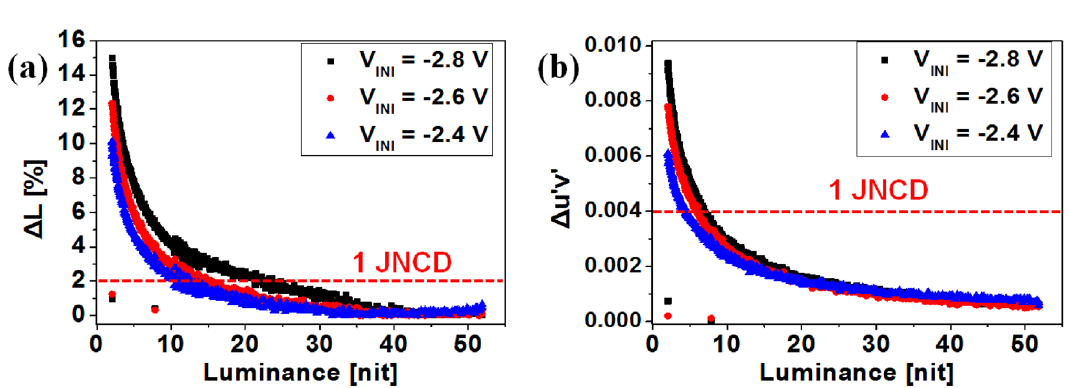
Figure 6. ( a ) The luminance and ( b ) color differences for a frequency change from 60 to 120 Hz, with fixed initial voltages of − 2.8, − 2.6, and − 2.4